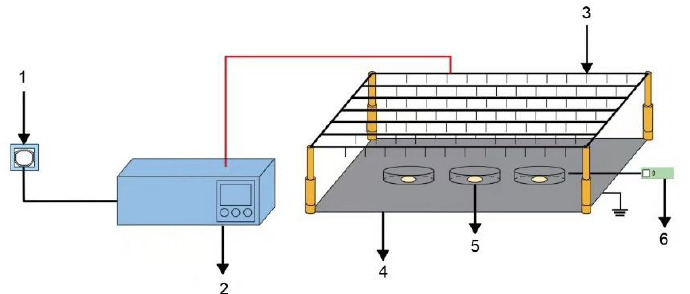
Figure 1. EHD drying system. 1. Power source; 2. High-voltage power supply control system; 3. Needle electrode; 4. Ground electrode; 5. Sample; 6.